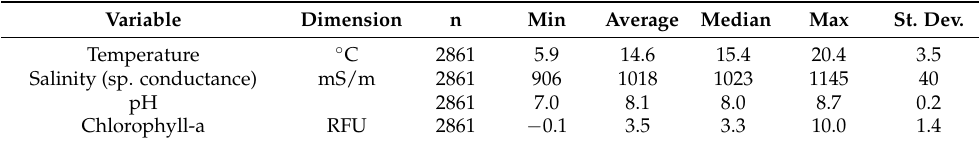
Table 2. Descriptive statistics for the four water property